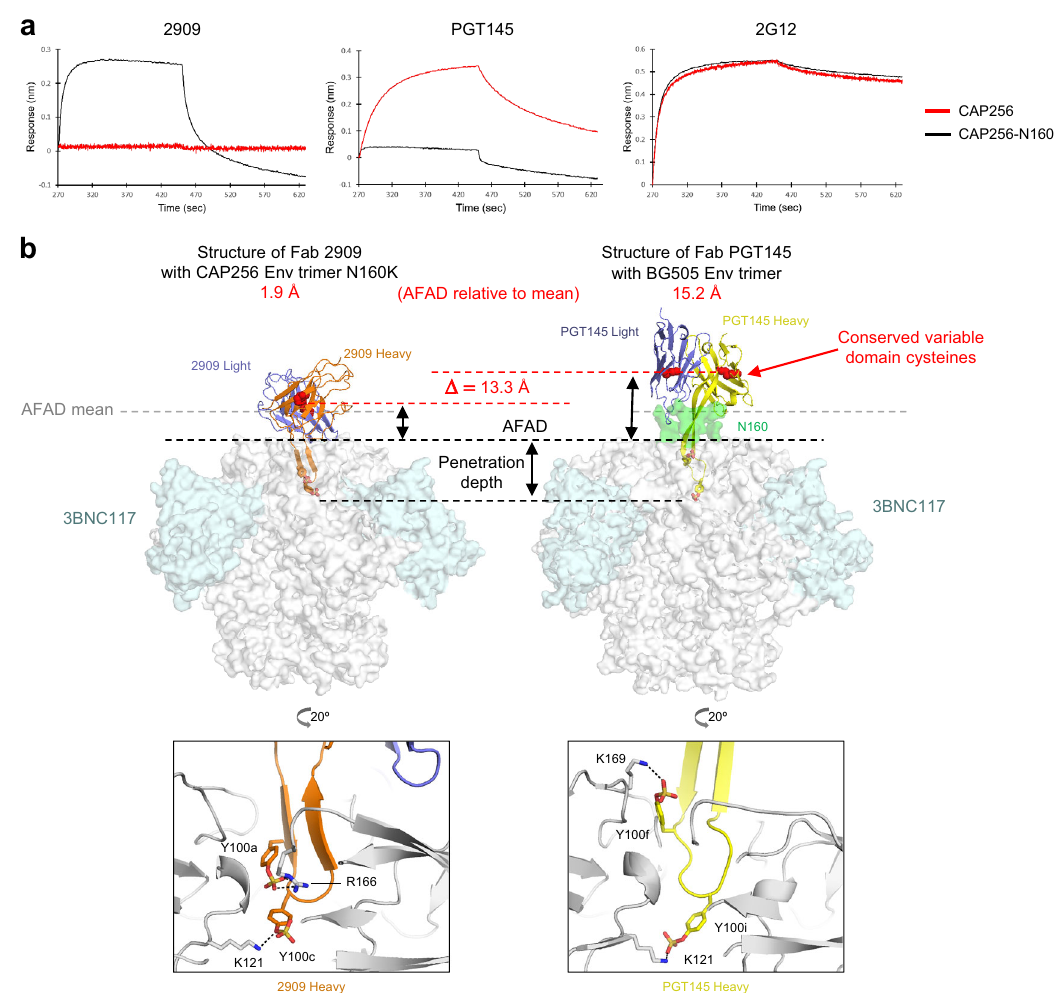
Fig. 4 Structure of N160K glycan-hole recognizing antibody 2909 with Env trimer reveals similar recognition to PGT145, but with ~13 Å closer approach. a CAP256.wk34.c80 SOSIP.RnS2 Env trimer variants containing the native N160 glycan site (CAP256-WT) or the N160K mutation (CAP256- N160K) were assessed for binding to 2909, PGT145, and 2G12 antibodies using biolayer interferometry. b Cryo-EM structure of CAP256-N160K Env trimer (surface representation in gray) in complex with the Fabs from antibodies 2909 and 3BNC117; inset shows CDR H3 region of 2909 penetrating the apex of the trimer with two sulfated tyrosines, Tys100c shown interacting with K121; CDR H3 length is 21 in Kabat (left). Cryo-EM structure of BG505 Env trimer (surface representation in gray) in complex with the Fabs from antibodies PGT145 and 3BNC117 (PDB: 5V8L); inset shows CDR H3 region of PGT145 penetrating the apex of the trimer with two sulfated tyrosines, Tys100i shown interacting with K121. CDR H3 length is 31 in Kabat (right). See also Supplementary Fig. 6 and Supplementary Table